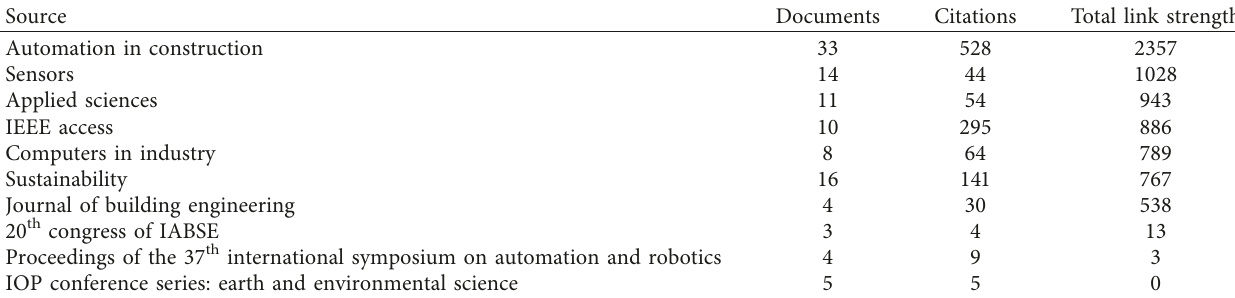
Table 1: Top journals and conferences with relevant published papers (2017–2022).